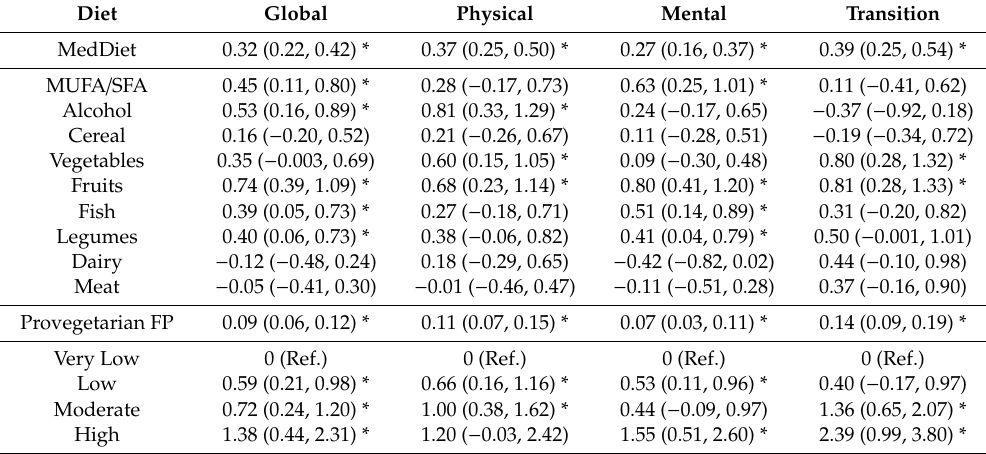
Table 4. Multivariable regression models with β -coe ffi cients (95% CI) of dietary characteristics for each of the SF-36 questionnaire summary